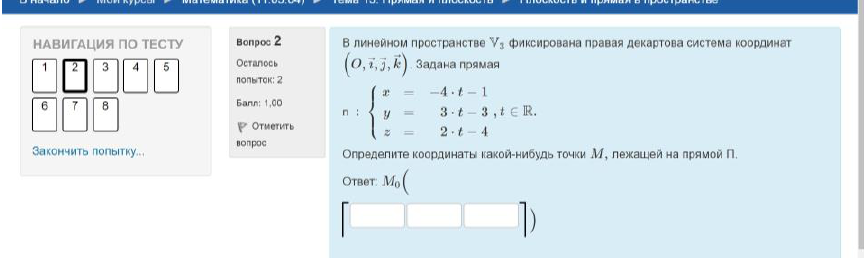
Fig. 2. STACK question on the parametric method of the line setting (TUSUR) / To start, my courses, Mathematics (11.03.04), Theme 13. Line and plane, plane and line in space / test navigation, finish attempt / question, attempts left, score, mark the question / in linear space the right Cartesian coordinate system is fixed. The line is settled. Determine the coordinates of any point that lies on the line. Answer.